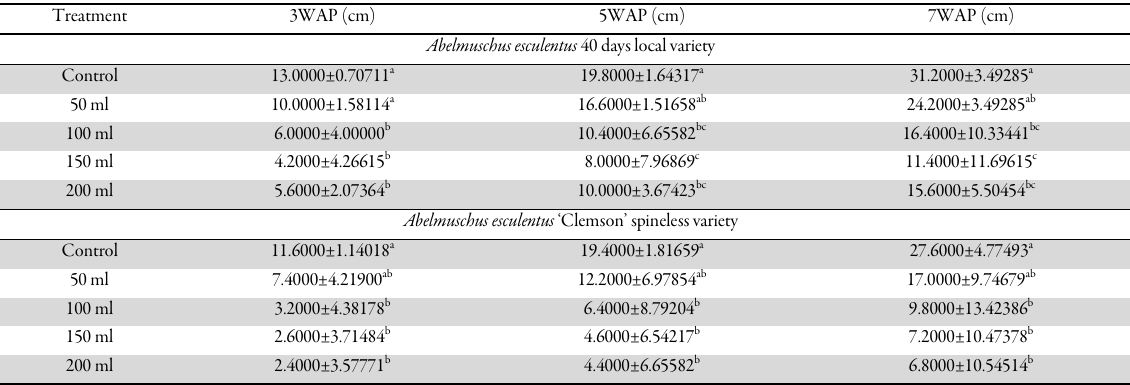
Table 3. Plant heights as affected by different concentrations of spent engine oil